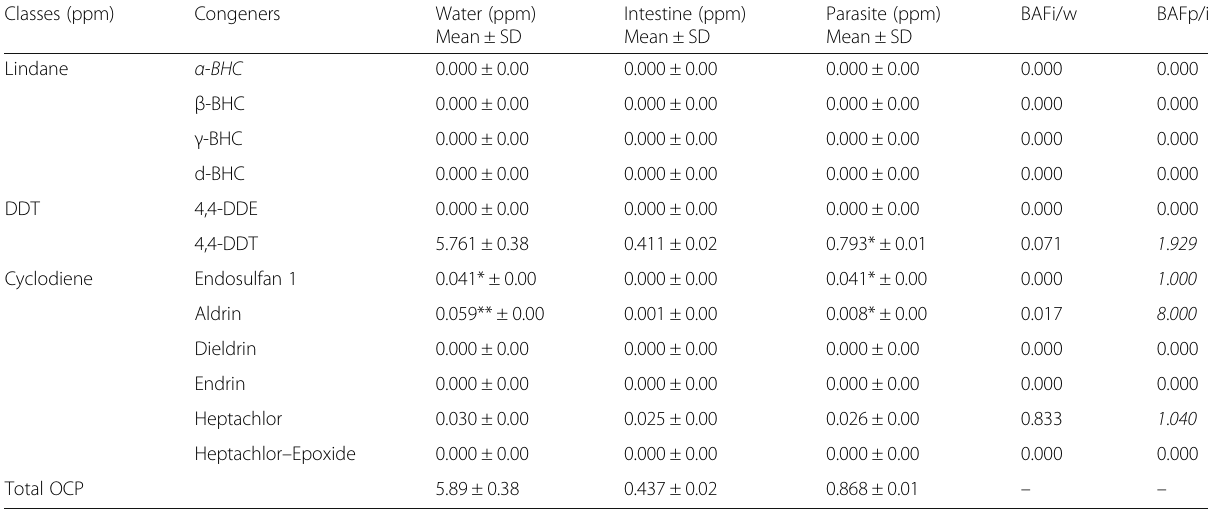
Table 4 Bio-concentration factor of OCPs in water-fish ( S . clarias )-parasite ( W . acuminata ) OCP congeners Classes (ppm)